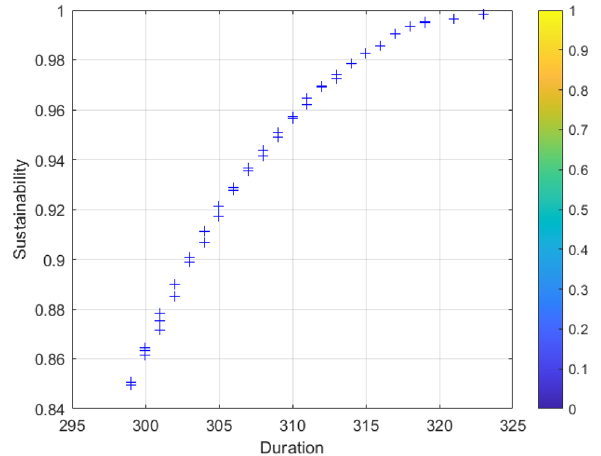
Figure 6. Sustainable-duration balance analysis.